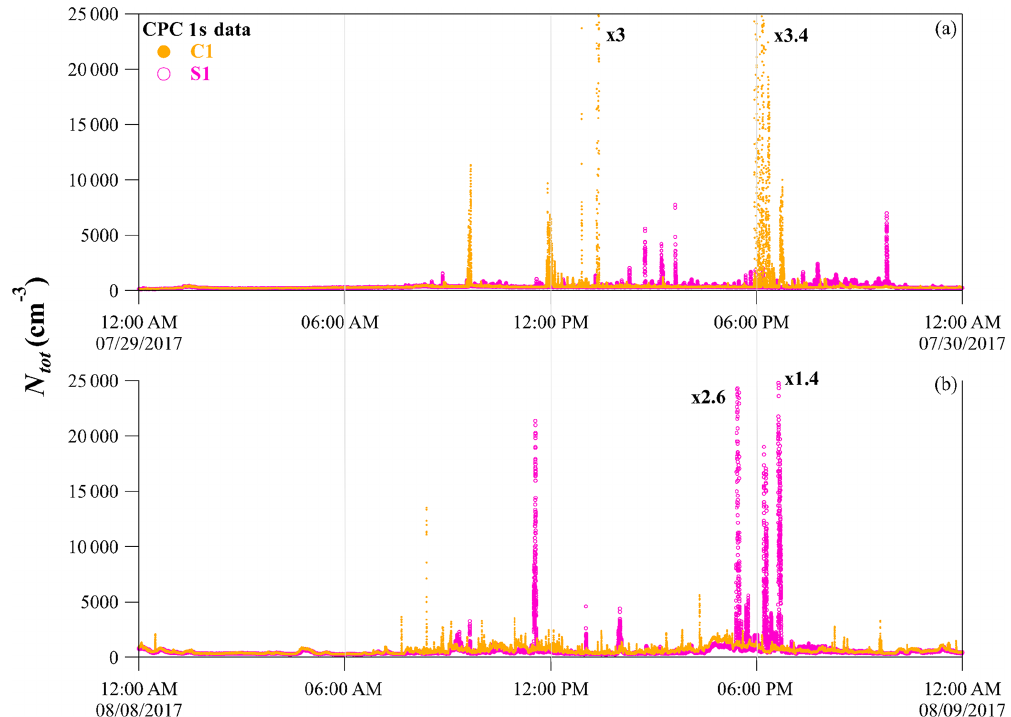
Figure 5. The 1s N tot data during two 1d periods at C1 (orange) and S1 (pink) raw in the summer. (a) Typical day when C1 sampled higher N tot than S1; (b) atypical day when S1 sampled higher N tot than C1. To highlight the smaller peaks, the four highest peaks are off-scale by the factors indicated in the